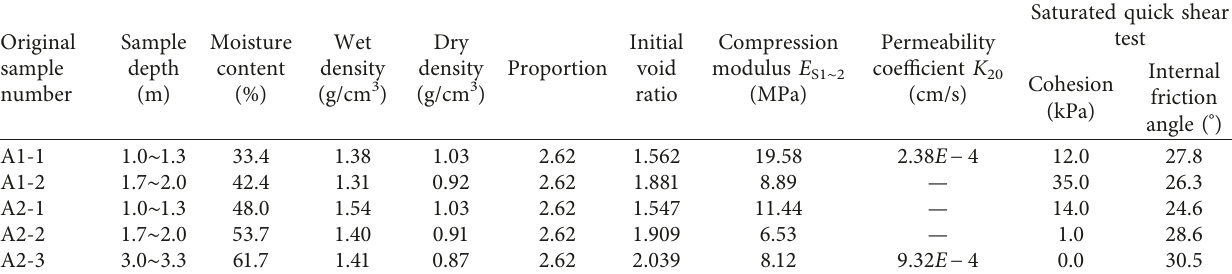
Table 1: Laboratory test results of fly ash.